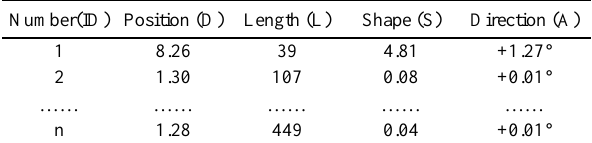
TABEL 1. Calculation results of line element object